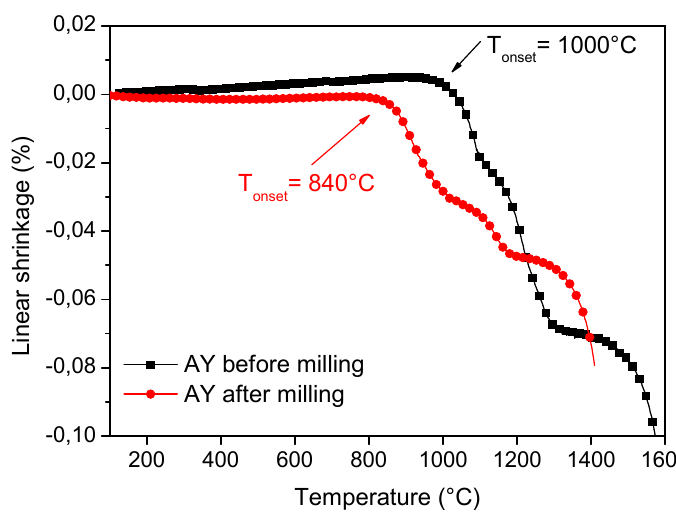
Figure 4. Linear shrinkage versus sintering temperature (during the heating step) of un-milled (black curve) and milled (red curves) AY powders. Maximum sintering temperatures were 1420 °C and 1600 °C for the milled and un-milled powders, respectively [34].